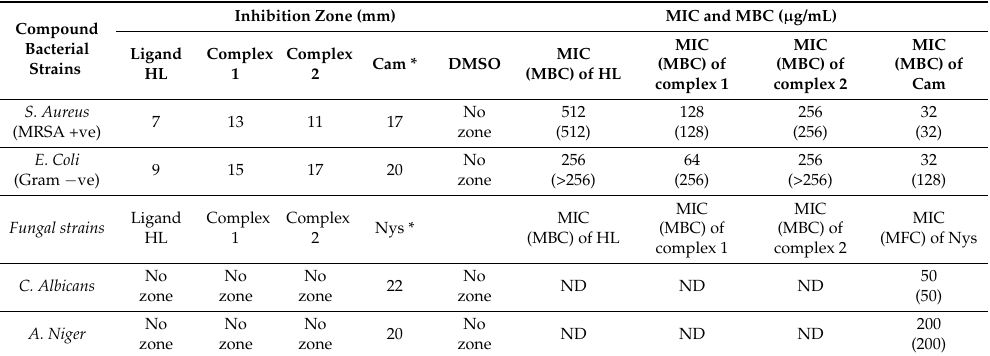
Table 3. Antimicrobial activity of azo-azomethine ligand and its